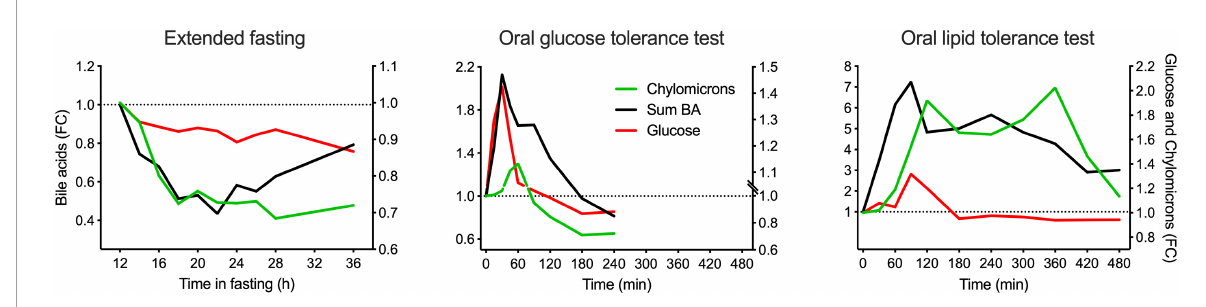
FIGURE5 Comparison of the kinetic behaviors of BA (total), glucose, and chylomicrons in plasma in the postprandial state and during the extended fasting period. Plasma concentration of the sum of all BA quantified is represented in the left Y -axis, whereas plasma concentration of chylomicrons and glucose are represented in the right Y -axis. Data are expressed as the fold-change relative to the baseline and presented as mean ± SEM ( N =